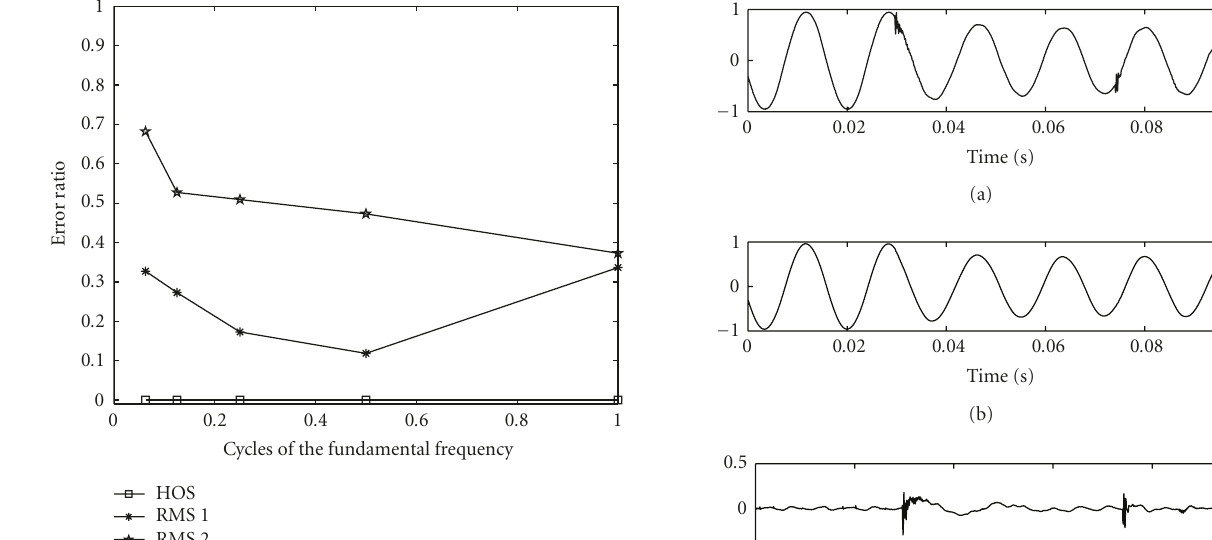
bances in voltage signals, Figures 13 and 14 show real voltage signals obtained from IEEE working group P1159.3 website, { x ( n ) } , and their corresponding { f ( n ) } and { u ( n ) } com- ponents, which are extracted in accordance to the proposed technique, and Figures 15 and 16 depict the extracted HOS- based parameter from these signals. L N = 128 for { x ( n ) } and { f ( n ) } signals and L N = 8 for { u ( n ) } signals.